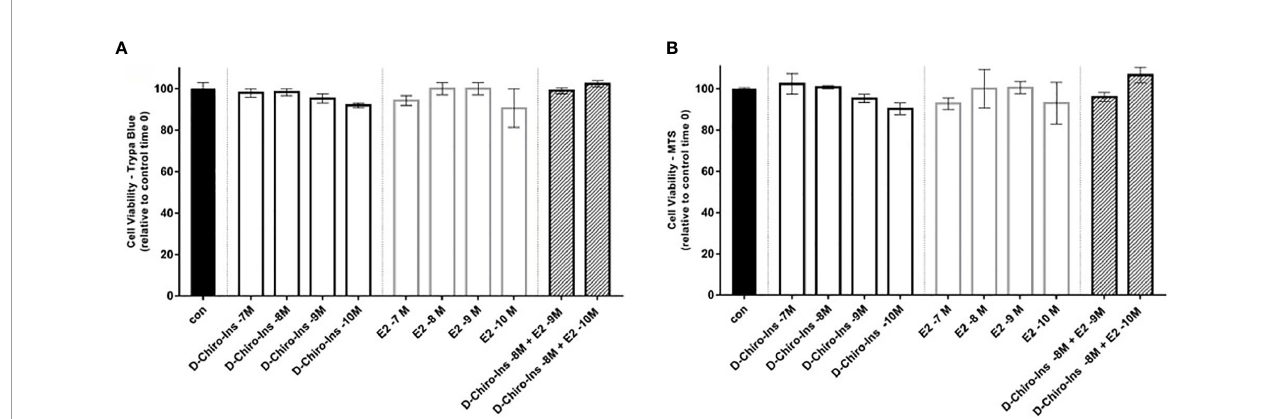
FIGURE 1 | D-Chiro-Ins does not affect SGBS cells viability. SGBS cells viability was measured by trypan blue assay (A) , or MTT assay (B) after 24-hour treatment with increasing concentration of D-Chiro-inositol (D-Chiro-Ins), 17 b -estradiol (E2) or combinations of D-Chiro-Ins and E2. All the results represent the media out